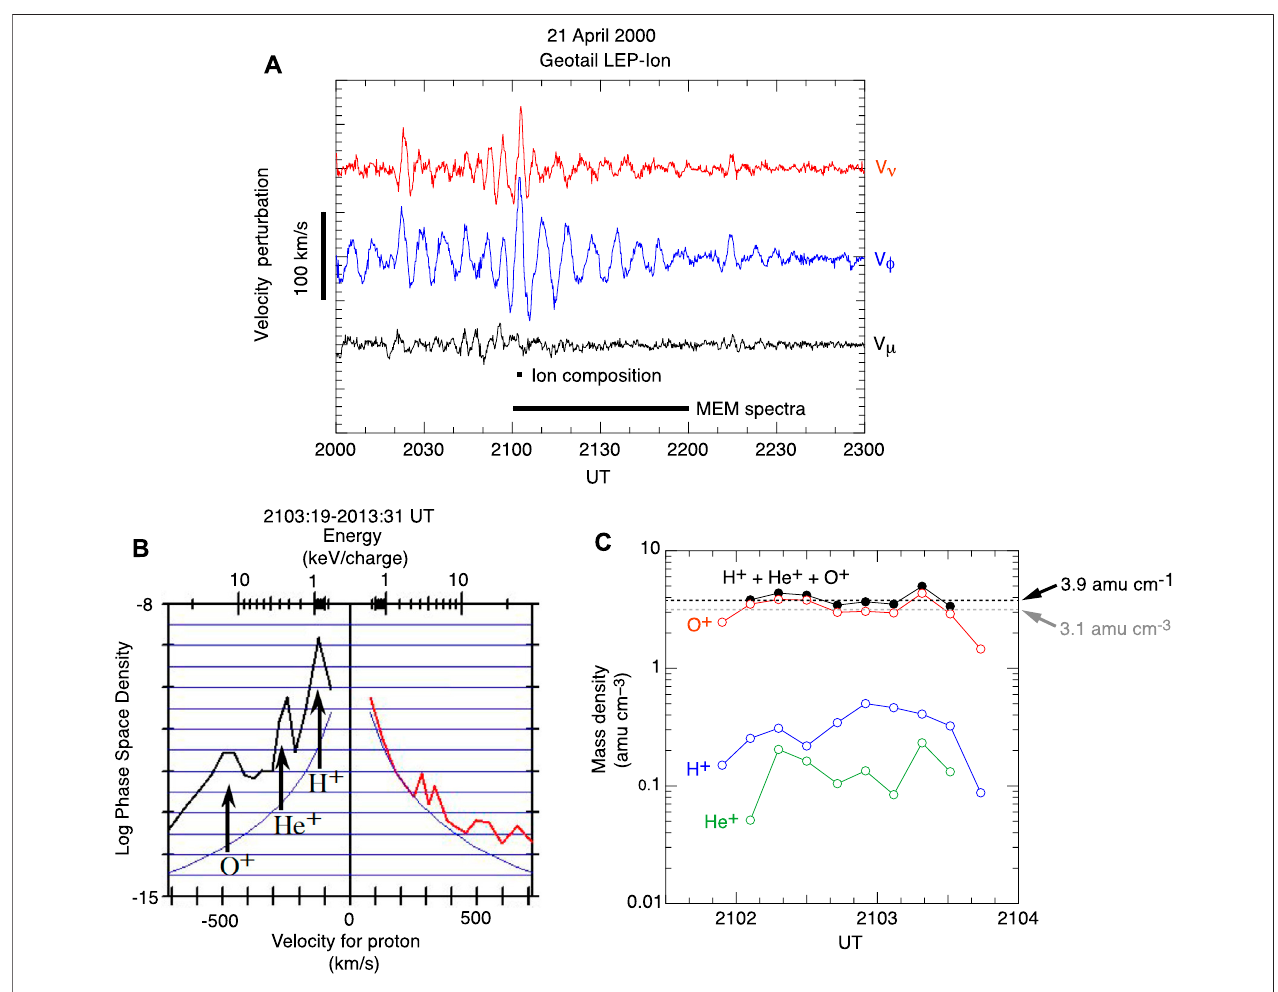
FIGURE9 | Massdensity analysisusing Geotail data. (A) Ion bulk velocity dataindicating aPc5 fundamental toroidal wave event (after Takahashi et al., 2014). The frequencyofthe V ϕ oscillationis2.2 mHzaccordingtothe V ϕ powerspectrumcomputedfromthe1-hdatasegmentlabeled “ MEMspectra. ” (B) Ionphasespacedensity snapshot obtained using ion fl uxes measured in a 12-s interval during the wave event (after Hirahara et al., 2004). (C) Partial and total mass densities obtained using the phasespacedensityforthe2.5-minintervallabeled “ Ioncomposition ” inpanel (A) (afterTakahashietal.,2014).Theblackandgrayhorizontaldashedlinesindicate the mass densities derived from the ion data and from the Pc5 wave frequency,